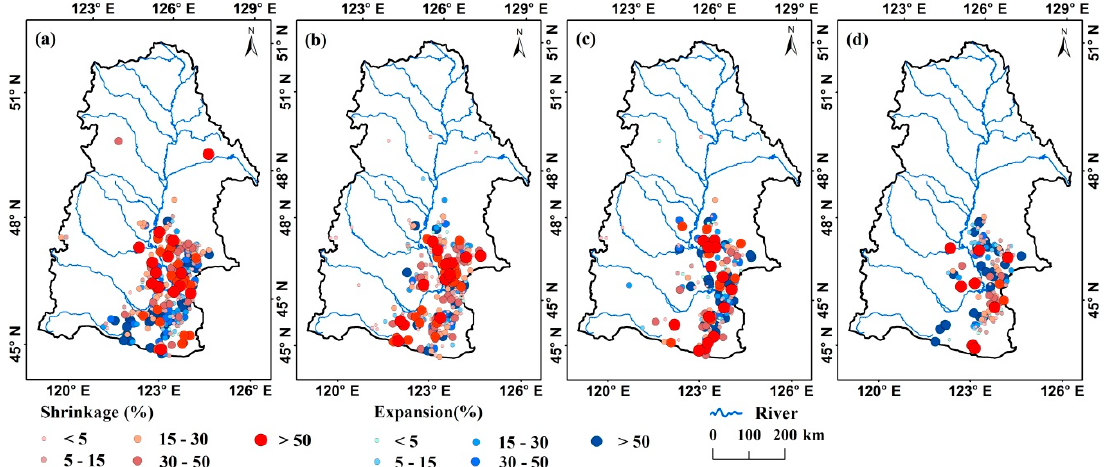
Figure 6. Spatial variations of lake changes in the Nenjiang watershed during different periods. Red and blue dots present lake shrinkage and expansion, respectively, while the dot extent denotes change proportion in the corresponding period. ( a – d ) represent the periods 1980–1990, 1990–2000, 2000–2010, and 2010–2015, respectively.